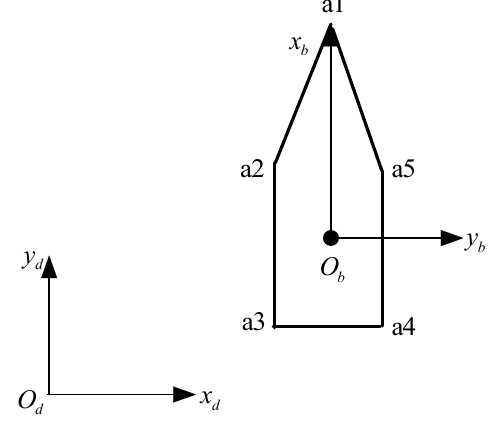
Figure 1. Diagram of simplified model of carrier aircraft.